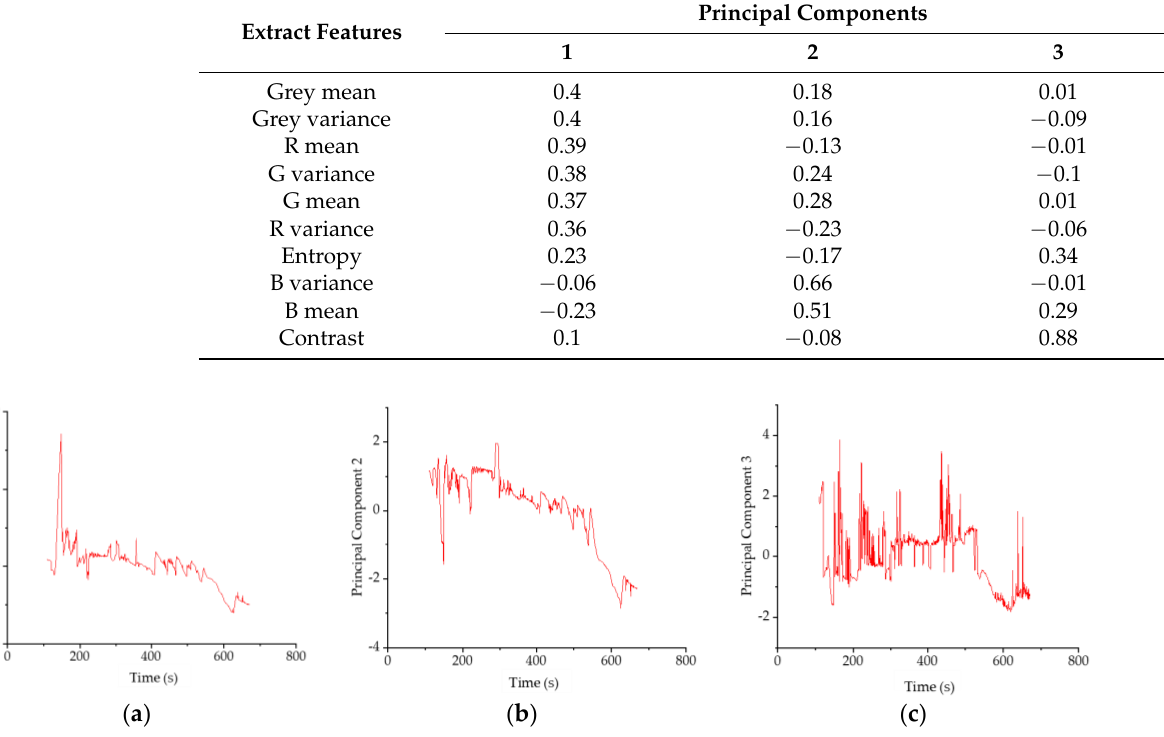
Figure 9. Changes in principal components 1, 2 and 3 over time. ( a – c ) Correspond to principal components 1, 2 and 3, respectively.